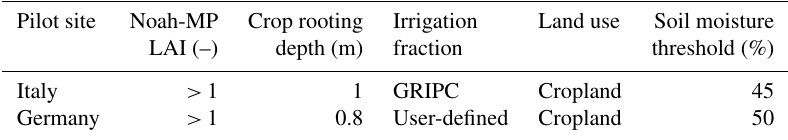
Table 1. Parameters needed to activate the irrigation scheme in Noah-MP, based on the two pilot sites. Pilot site Noah-MP Crop rooting Irrigation Land use Soil moisture LAI (–) depth (m) fraction threshold (%) Italy > 1 1 GRIPC Cropland 45 Germany > 1 0.8 User-defined Cropland